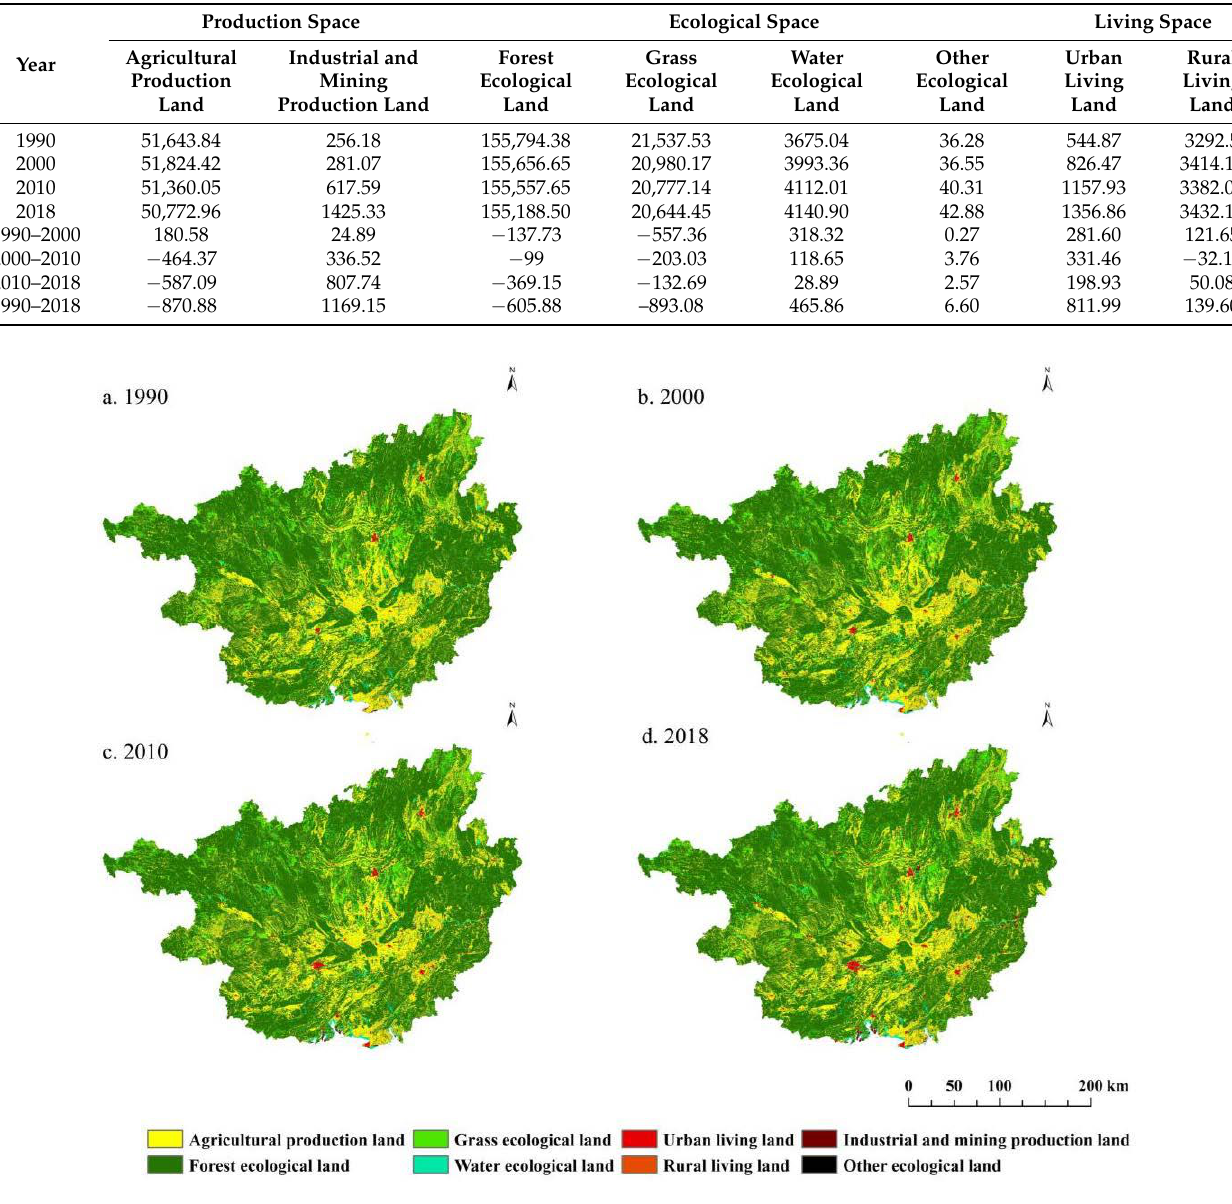
Table 2. Land use changes (km 2 ) of the PLES in Guangxi, China, during 1990–2018.